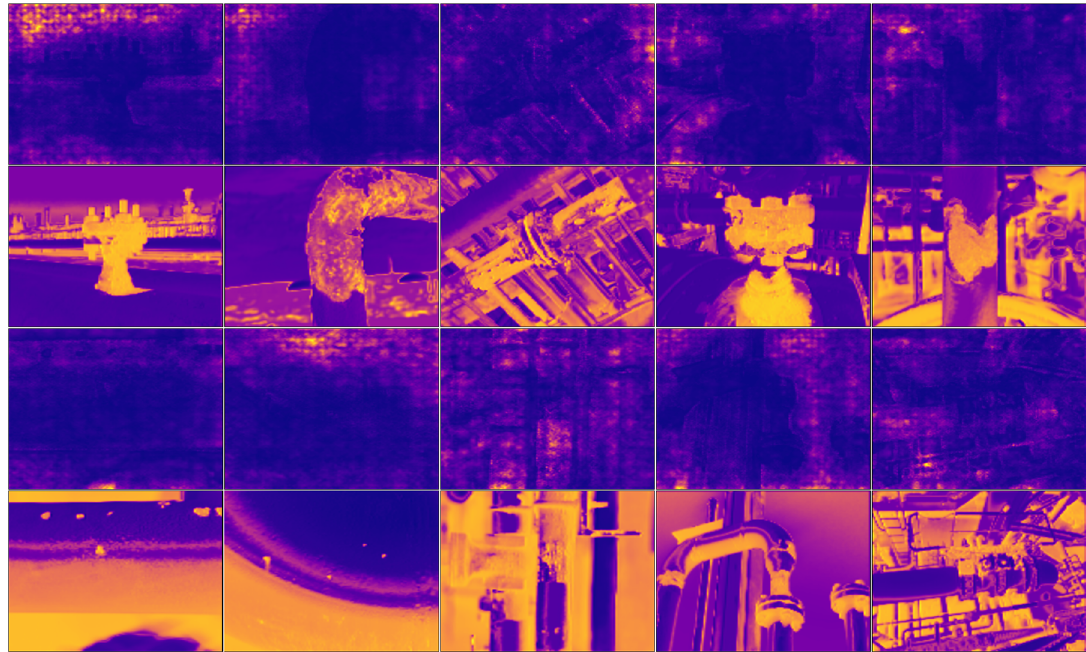
Fig. 10 Monte-Carlo dropout model uncertainty maps. The epistemic ( fi rst and third row) and aleatoric (second and fourth row) uncertainty maps produced by the Monte-Carlo dropout model for the example input images (Fig. 5). Colour scale from low = purple to high =